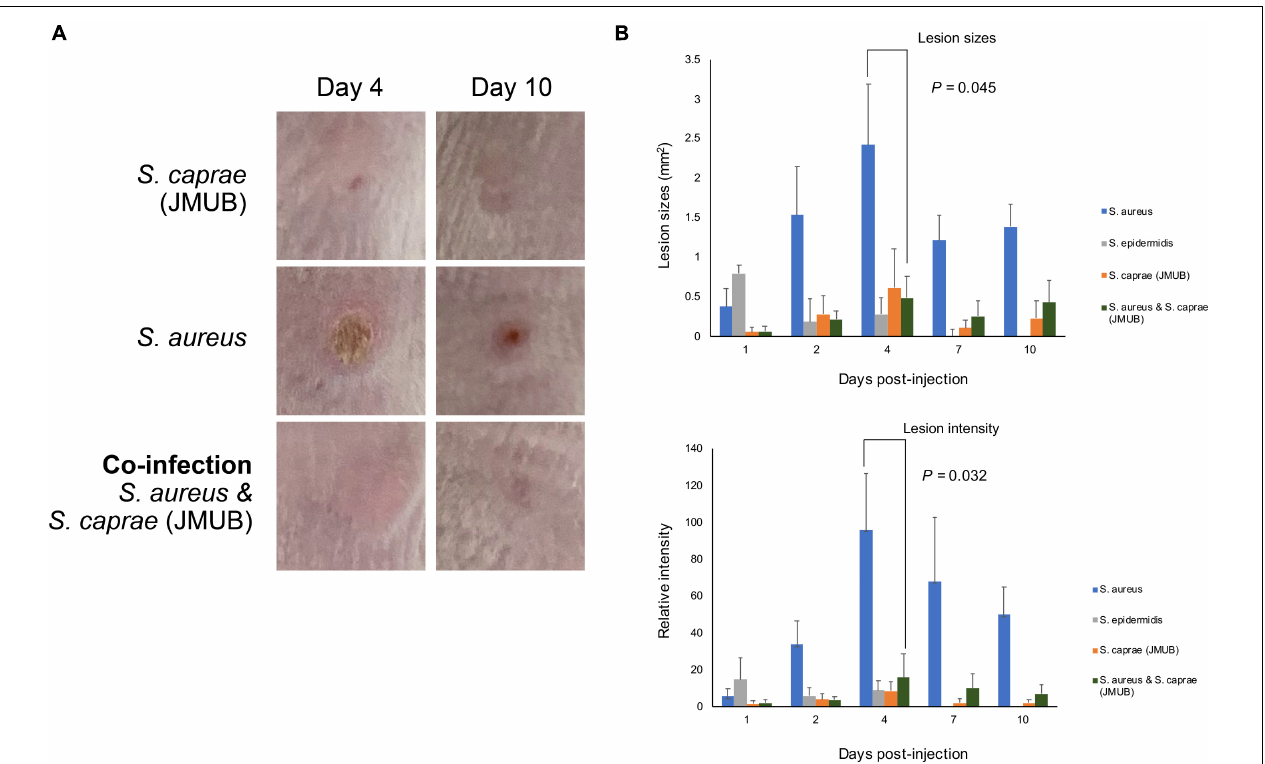
FIGURE 6 | Subcutaneous injection. (A) Representative images of lesions after subcutaneous injection. Picture sizes are 1 × 1 cm. The other images are shown in Supplementary Figure 5 . (B) Lesion sizes and intensity. The color intensity was calculated by ImageJ using normal skin (1 cm apart from injured sites) as control (=1). p -Values were calculated by Student’s t -test.